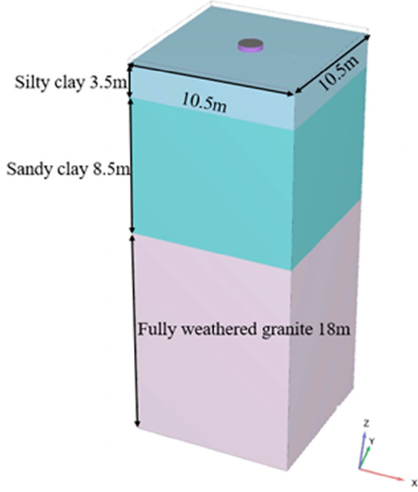
Figure 4. 3D finite element model.